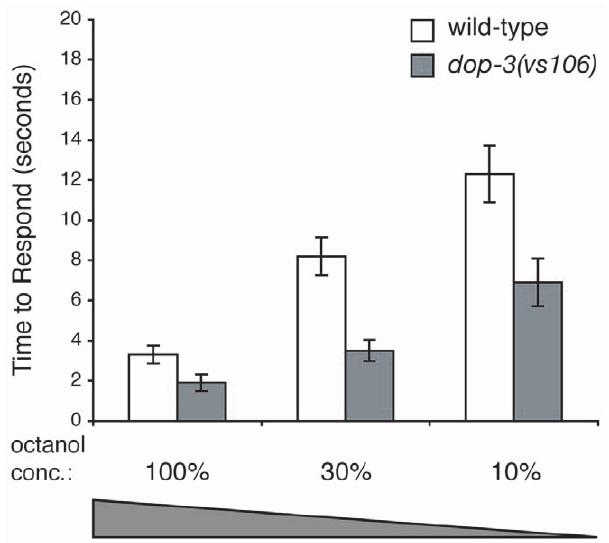
Figure 4. Loss of DOP-3 function results in enhanced sensitivity to dilute octanol. Loss of dopamine receptor DOP-3 function renders animals hypersensitive to dilute octanol. dop-3 animals respond better than wild-type animals to dilute octanol (p , 0.0001 for 30% octanol and p , 0.01 for 10% octanol). Allele used: dop-3(vs106) . WT = the N2 wild- type strain. The time to respond is shown. n $ 40. Error bars represent the standard error of the mean (SEM). Conc. = concentration.